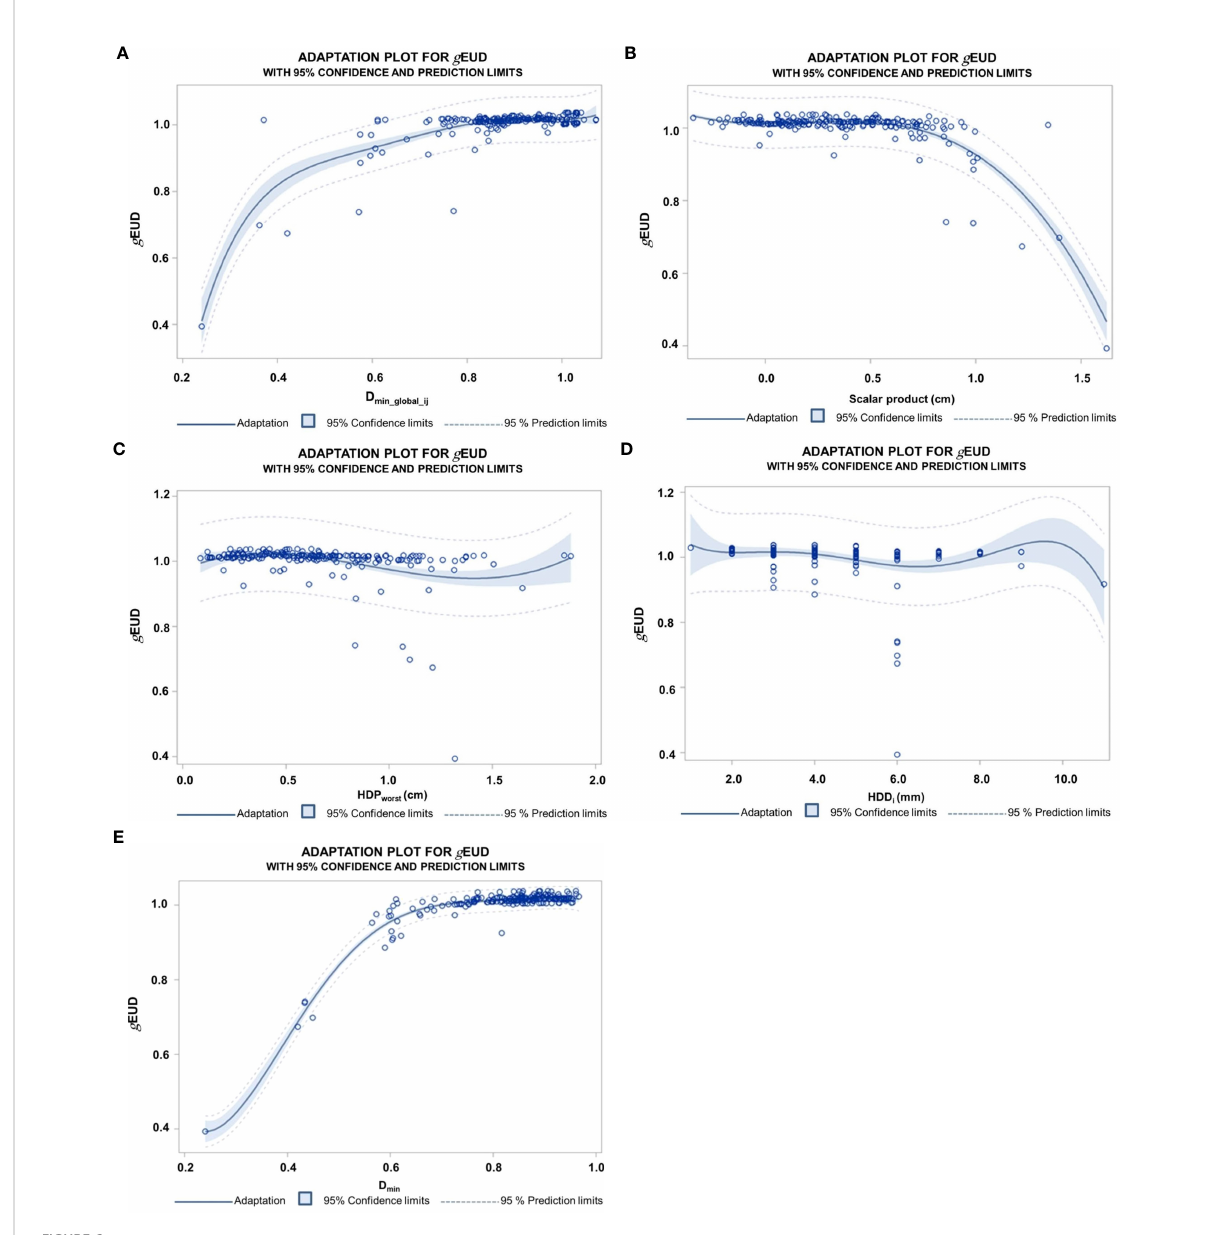
FIGURE 6 (A) Dependence of g EUD values normalized by the prescribed dose on the normalized dose at the global D min point (D min_global_ij ) over all 218 fractions from the 10 patients approximated by a polynomial fi t. The highest signi fi cant degree of the polynomial terms was 5; the coef fi cient of determination R square was 0.69. (B) Polynomial fi t of the normalized g EUD i by the length of the deformation vector at the global minimum point of the CTV overall fractions per patients in the direction of the steepest dose decline (Scalar PDmin_global_i_x ). The normalized g EUD i remained stable up to deformations of 8 mm, followed by a steep descent. The highest degree of a signi fi cant term was 3; the coef fi cient of determination was 0.69. The clinical PTV margin was 5 – 6 mm. (C) Polynomial regression of the normalized g EUD i values on the length of deformation vectors at HDP worst ( D L-HDP worst ). HDP worst represents the point on the CTV margin per patient with the largest Hausdorff distance to the deformed CTV i overall fractions and was given in cm. The degree of the polynomial is 3; the coef fi cient of determination is 0.13. (D) Fit of the normalized g EUD values by the Hausdorff distances HDD i between the deformed CTV i per fraction and the CTV on the planning CT overall fractions from the different patients. The degree of the polynomial is 5; the coef fi cient of determination is 0.08. (E) Fit of the g EUDi values normalized by the prescribed dose in dependence on the normalized D min over the 218 fractions from 10 patients. The degree of the fi tted polynomial is 5; the coef fi cient of determination is